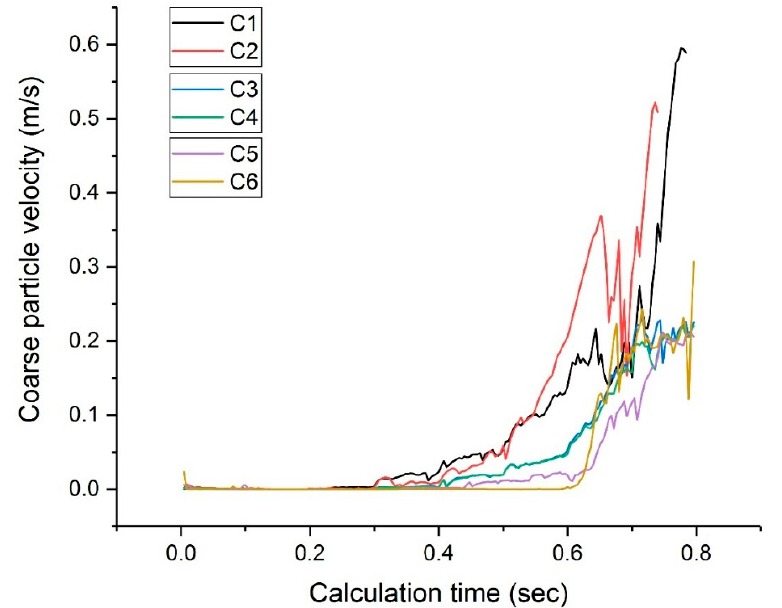
Figure 20. Evolution of coarse particle velocity in different layers (C1 and C2 are coarse particles in the top layer; C3 and C4 are coarse particles in the middle layer; and C5 and C6 are coarse particles in the bottom layer).